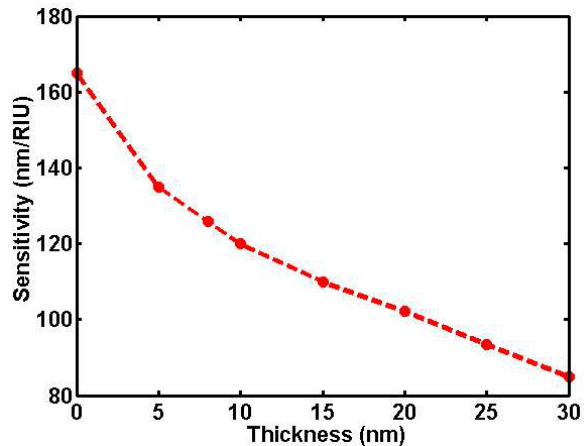
Fig. 8. The sensitivity as a function of the thickness of layer of the